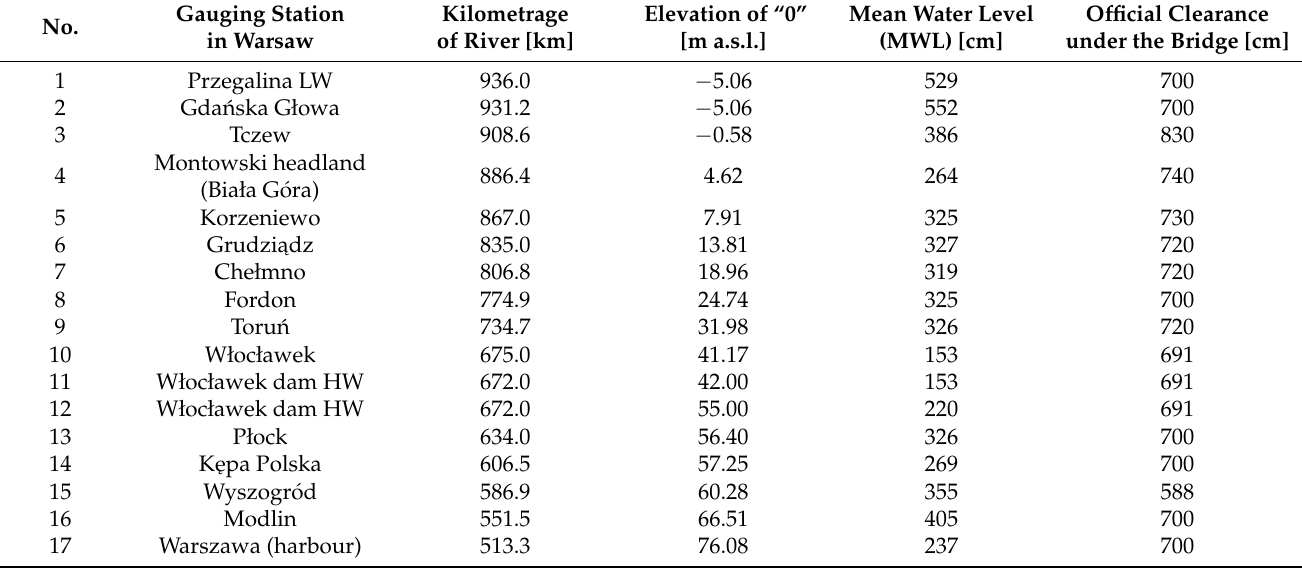
Table 1. Gauging stations on the Vistula waterway from Gda´nsk to